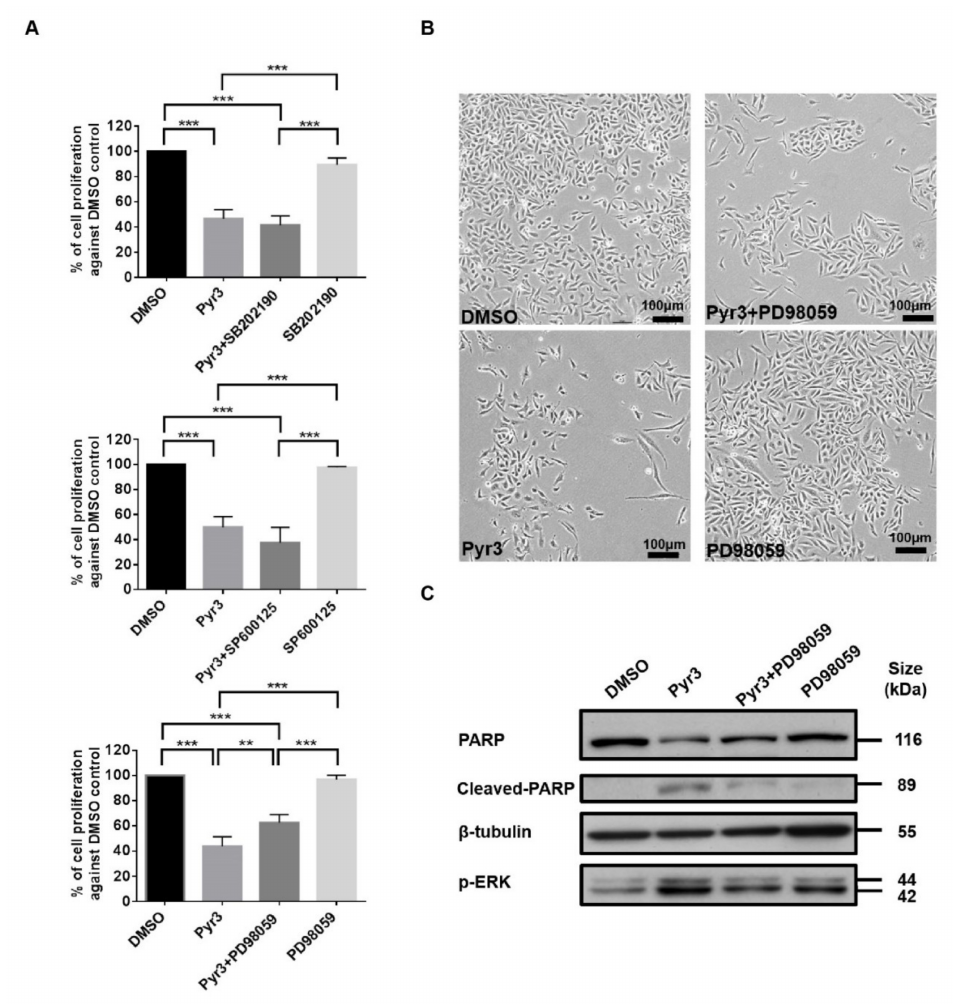
Figure 4. TRPC3 blockade induced apoptosis in MDA-MB-231 cells through activation of ERK 1 / 2. ( A ) decrease in the percentage of cell proliferation in response to Pyr3 (1.0 µ M for 72 h) was attenuated